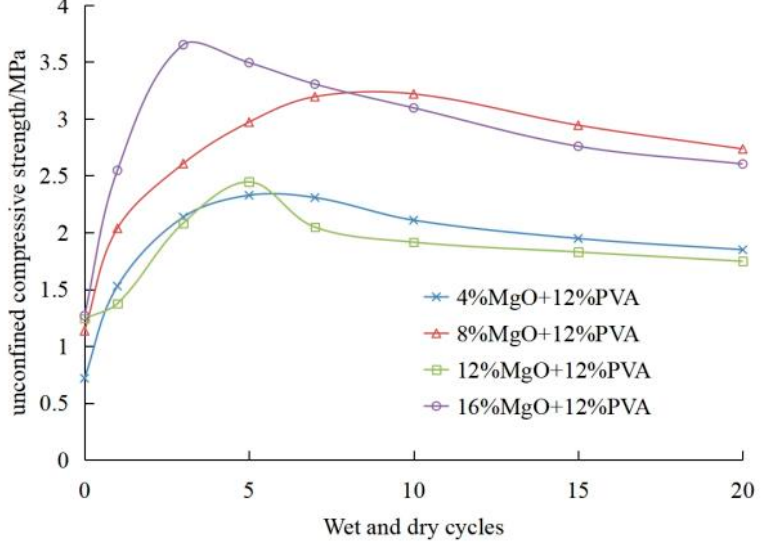
Figure 10. Curve of strength of sample with dry–wet cycle.